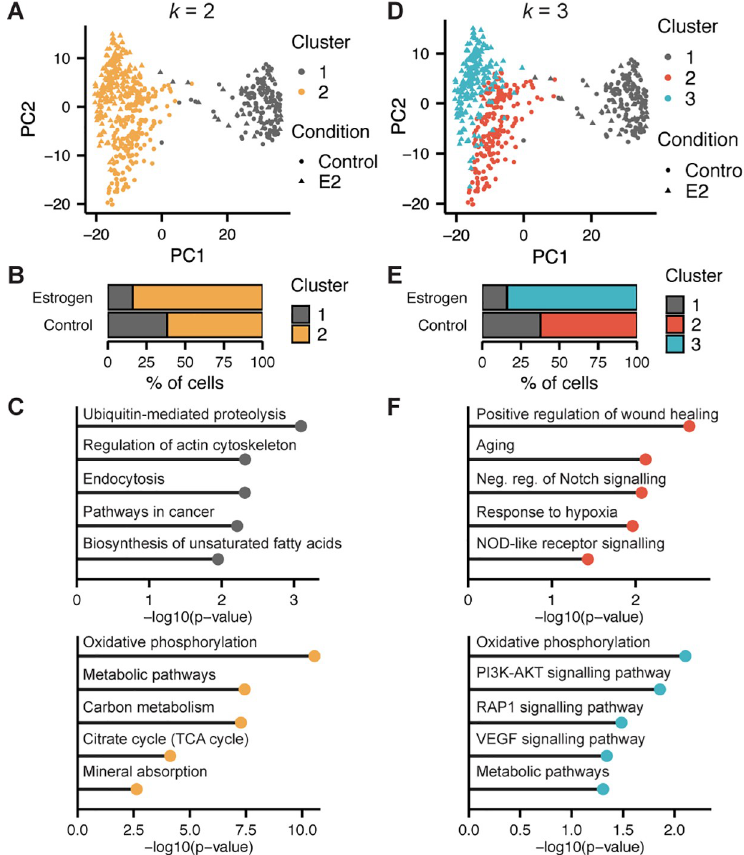
Fig 2. Unsupervised clustering reveals distinct heterogeneity in OSE. (A) PCA of OSE cells coloured by cluster ( k = 2 clustering). (B) Stacked barplot displaying the percent of cells from each condition within each cluster. (C) Top KEGG Pathways and GO Terms (p-value < 0.05) associated with genes more-highly expressed in Cluster 1 (top) and Cluster 2 (bottom). (D) PCA of OSE cells coloured by cluster ( k = 3 clustering). (E) Stacked barplot displaying the percent of cells from each condition within each cluster. (F) Top KEGG Pathways and GO Terms (p-value < 0.05) associated with genes more-highly expressed in Cluster 2 (top) and Cluster 3